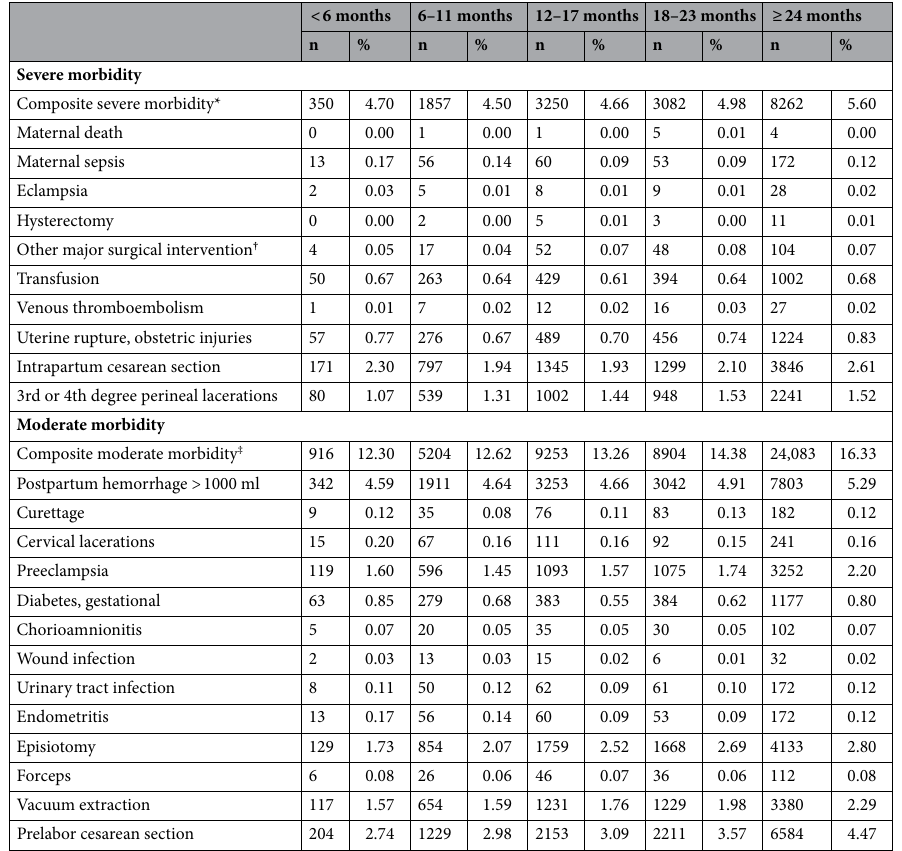
Table 2. Maternal morbidity in the second birth across interpregnancy intervals. *All components of severe morbidity presented below. † Uterine compression sutures (B-Lynch), uterine artery ligation or embolization, internal iliac artery ligation, intrauterine balloon tamponade. ‡ All components of moderate morbidity presented